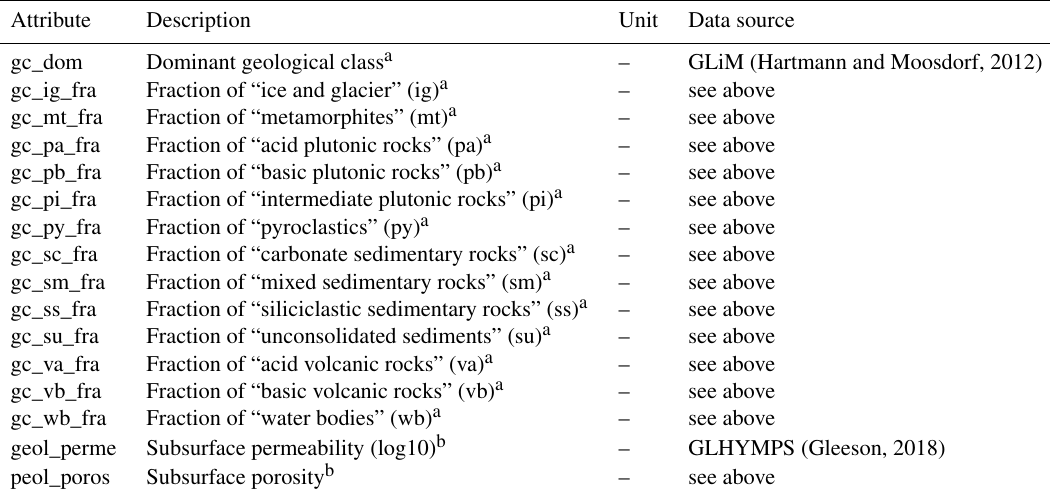
Table A9. Geological attributes.